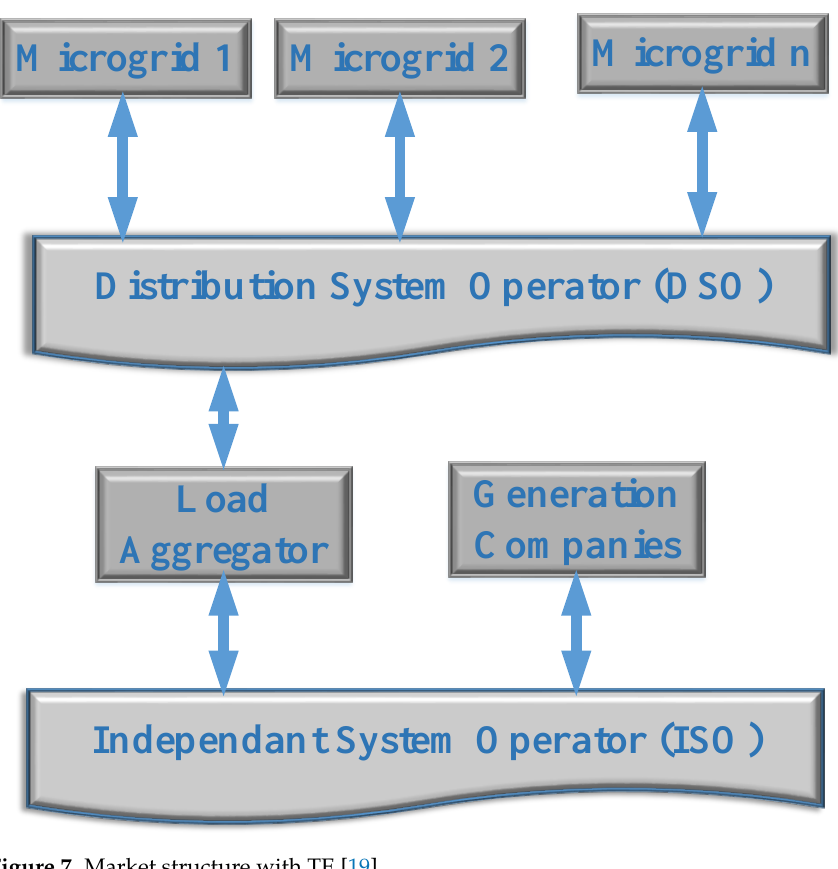
Figure 7. Market structure with TE